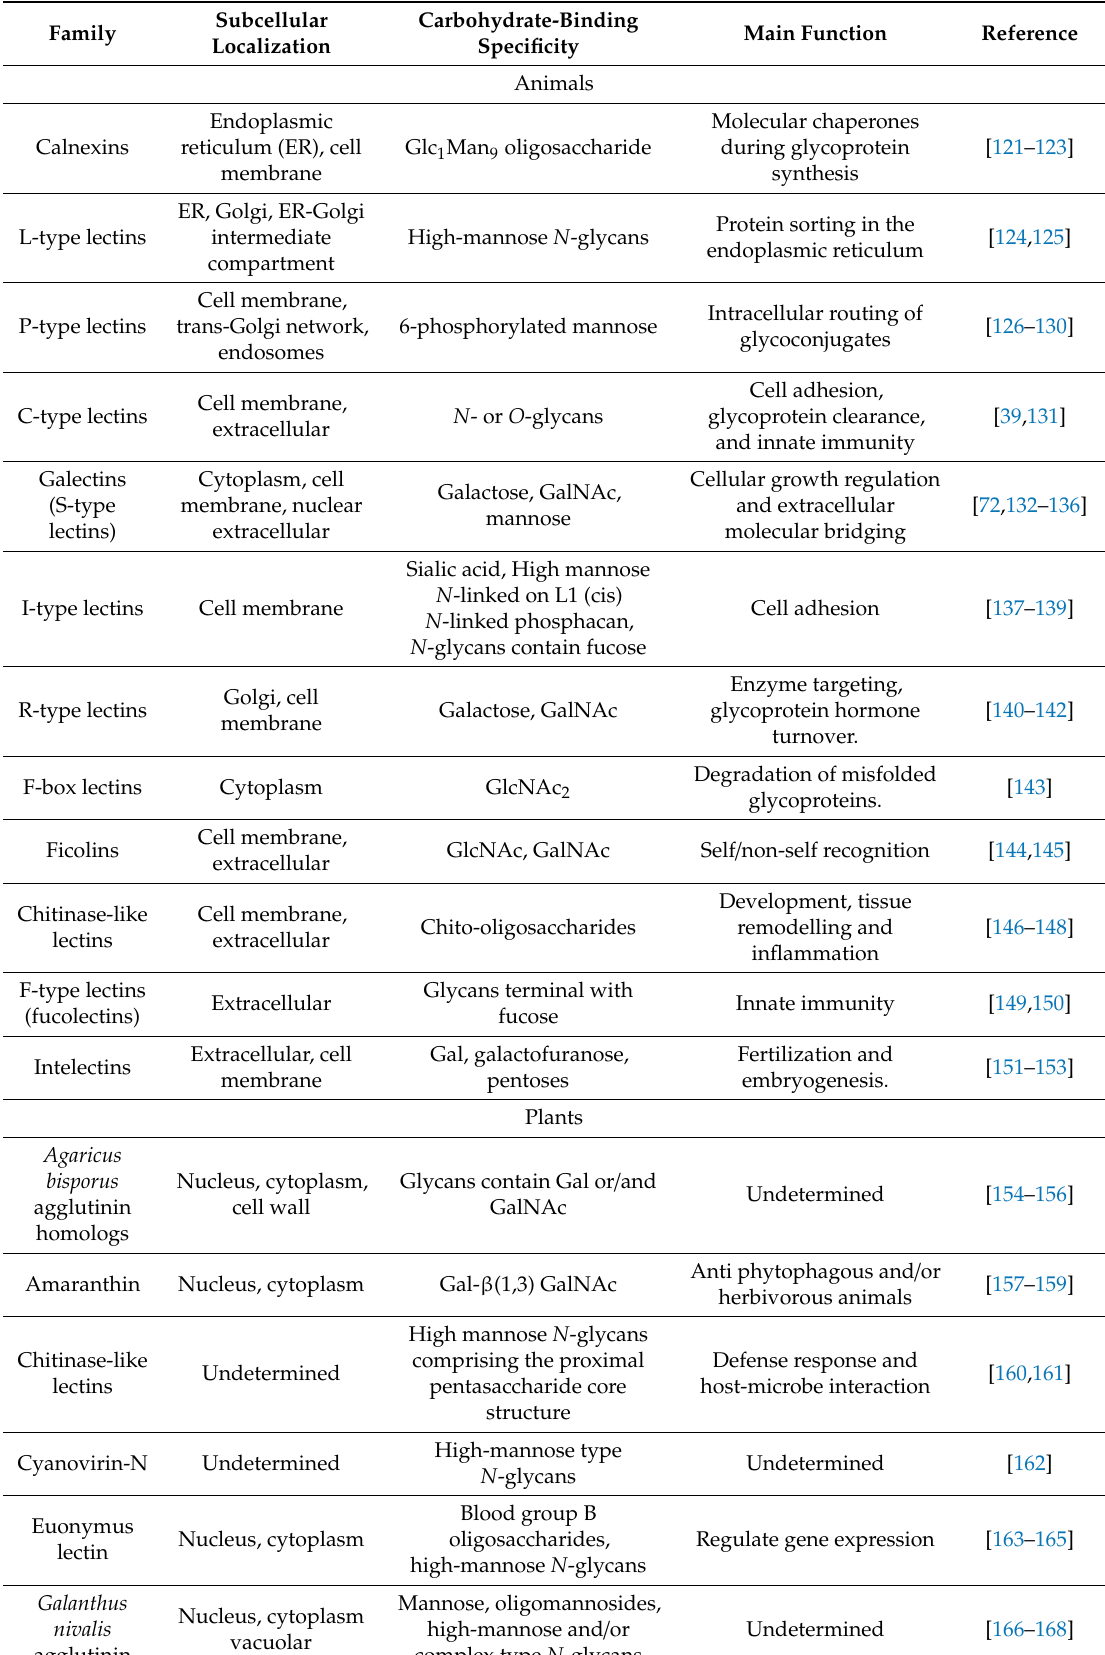
Table 2. The lectin families in animals and